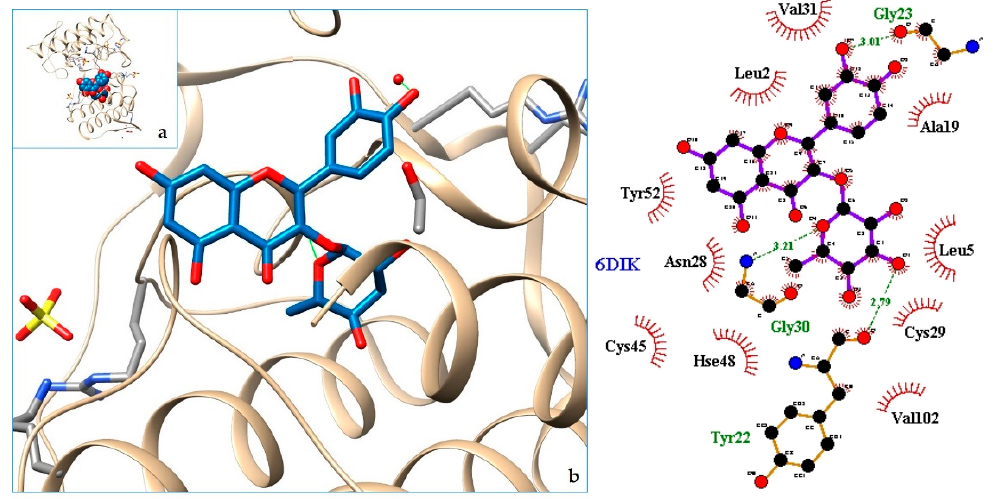
Figure 8. 6DIK-quercetrin complex in the most favourable arrangement ( a ) and augmented ( b ) showing the disposition between the chain of toxins. Right: 2D interaction